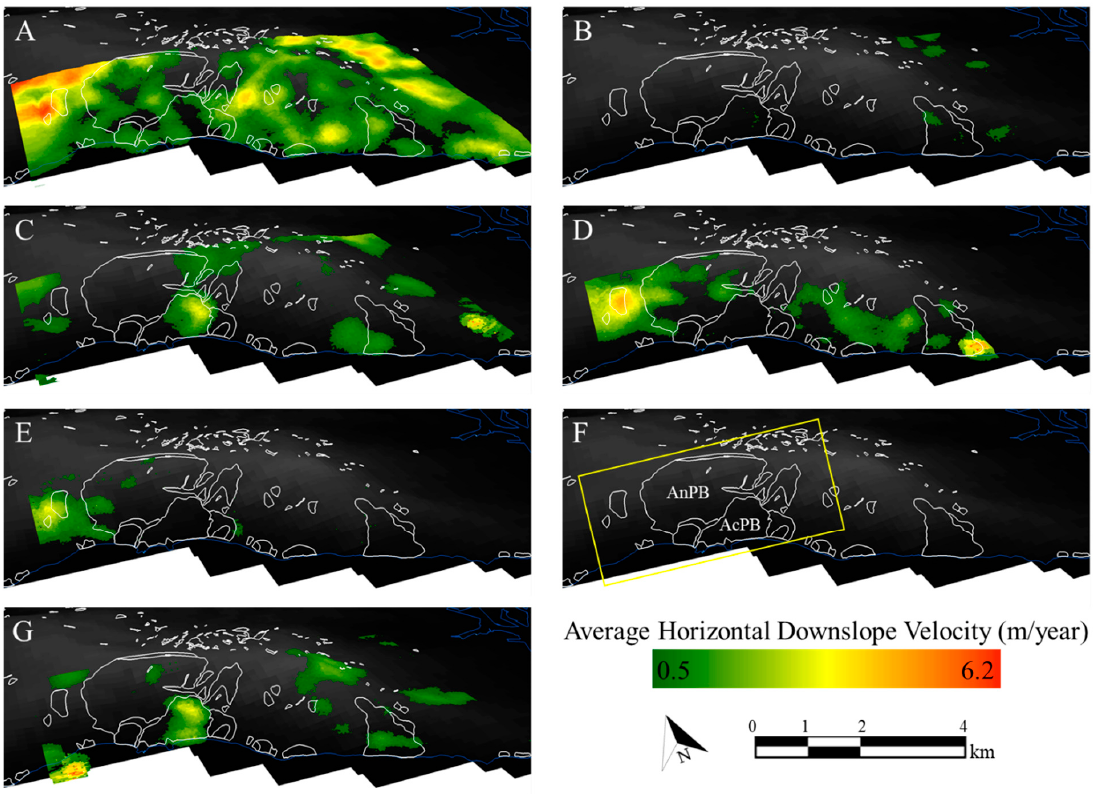
Figure 3. Incremental average horizontal downslope velocity (m/year) between chronological Worldview-2 image pairs. ( A ) 20 February 2011–29 May 2011; ( B ) 29 May 2011–17 February 2012; ( C ) 17